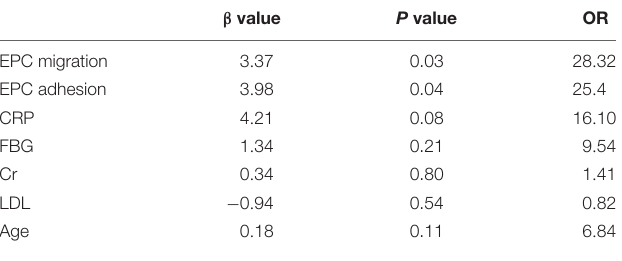
TABLE 2 | Multivariate logistic analysis for the correlation of FMD and relative